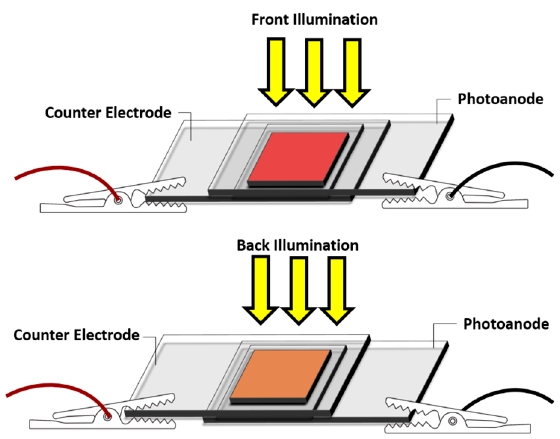
Figure 10. Schematic representation of the structure of BF-DSSC and photovoltaic performance evaluation after simulated solar irradiation.